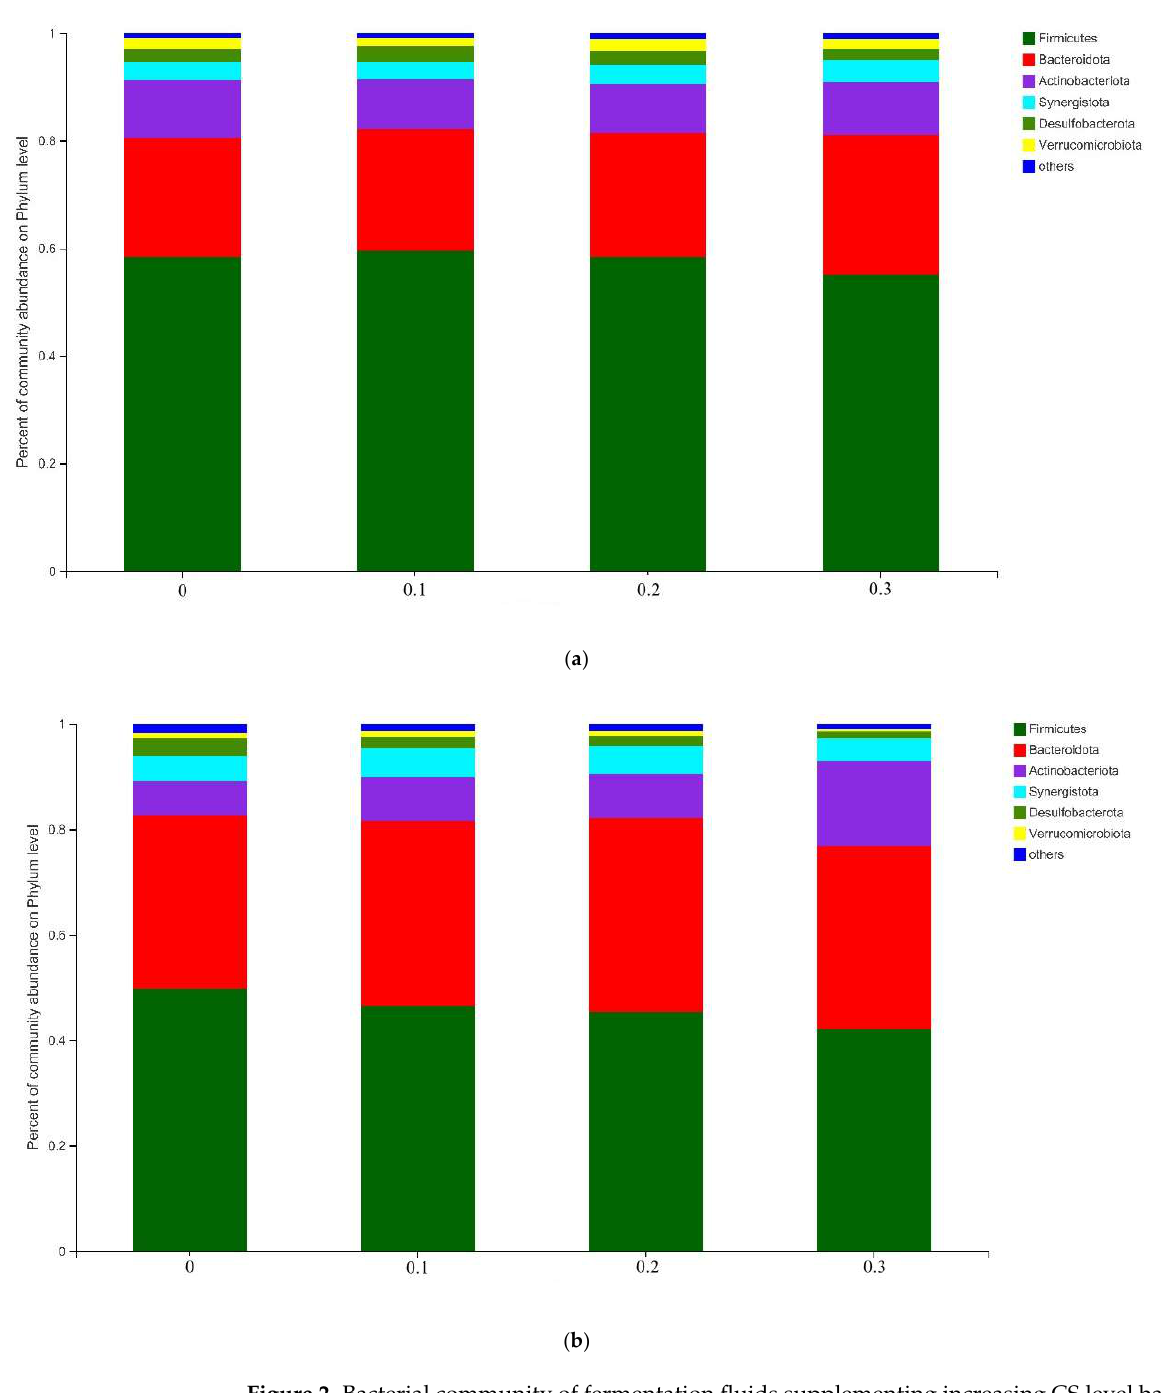
Figure 2. Bacterial community of fermentation fluids supplementing increasing CS level based on the phylum level in HF group ( a ) and LF group ( b ).